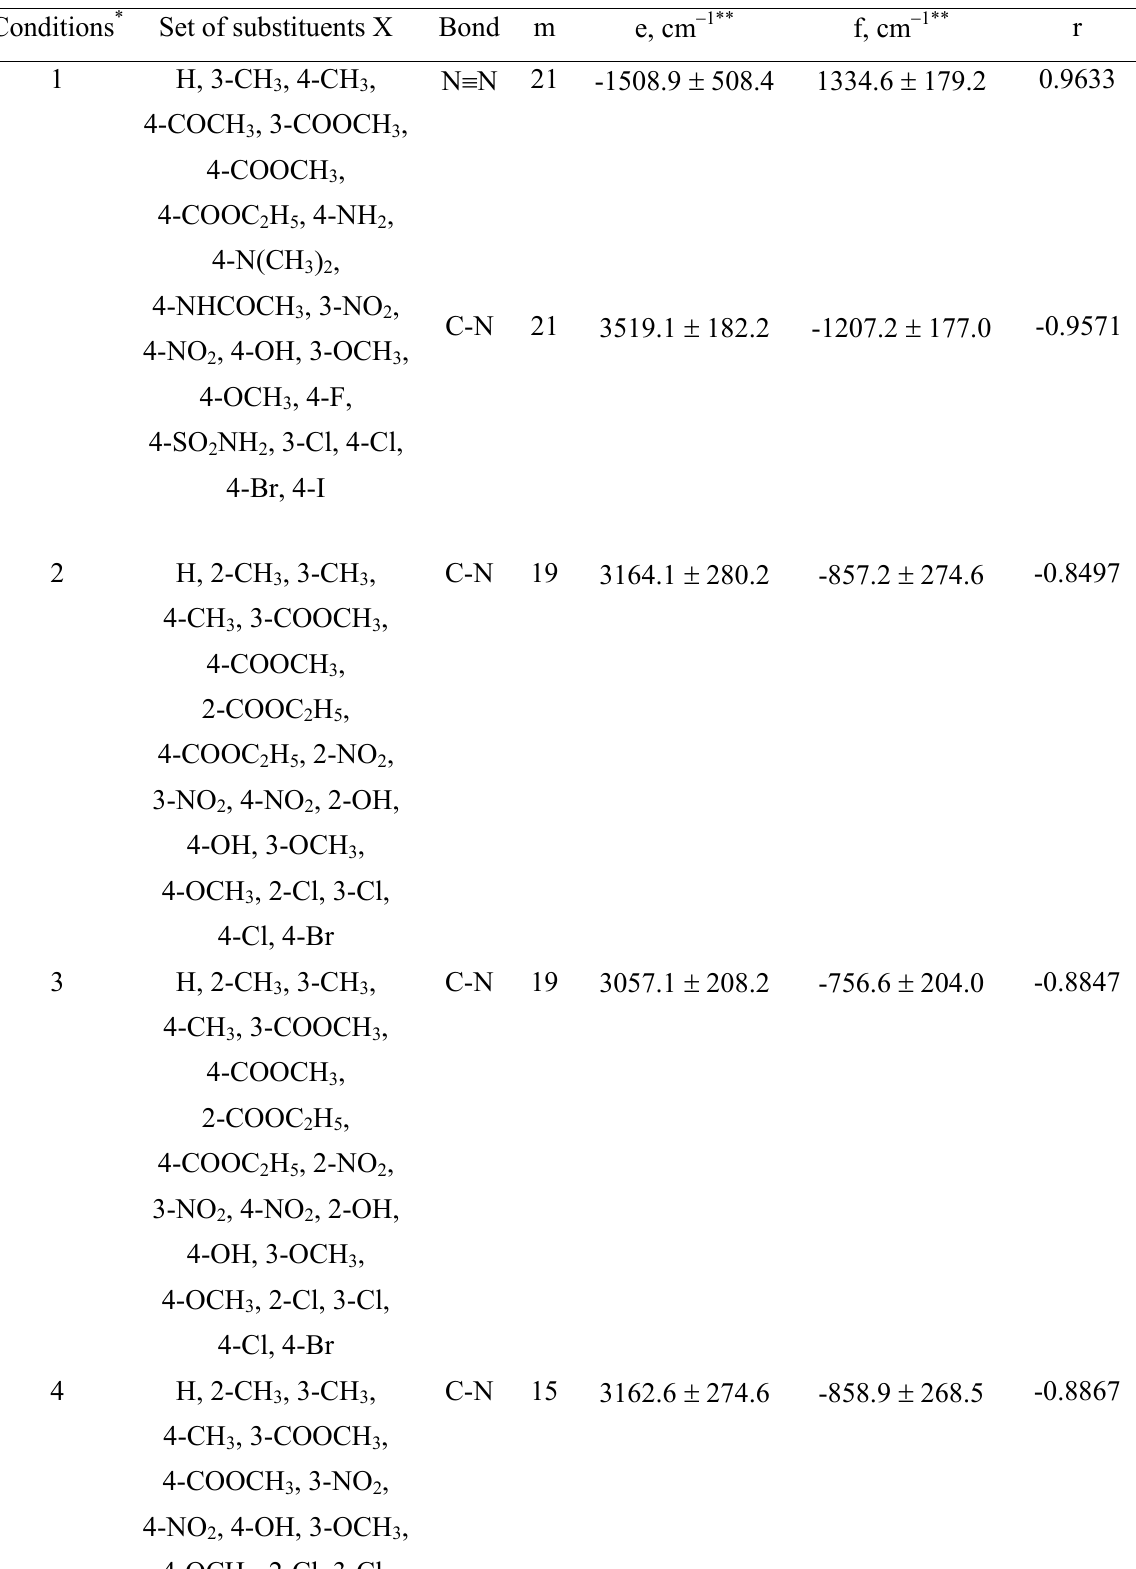
Table 3c. Correlations of stretching vibrational frequencies ( ν ) for fragment C-N + ≡ N bonds in Conditions